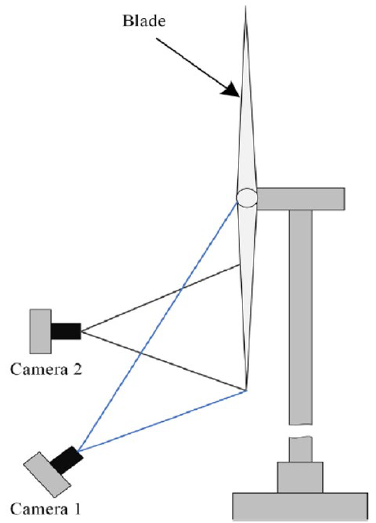
Figure 10. Machine vision [37].